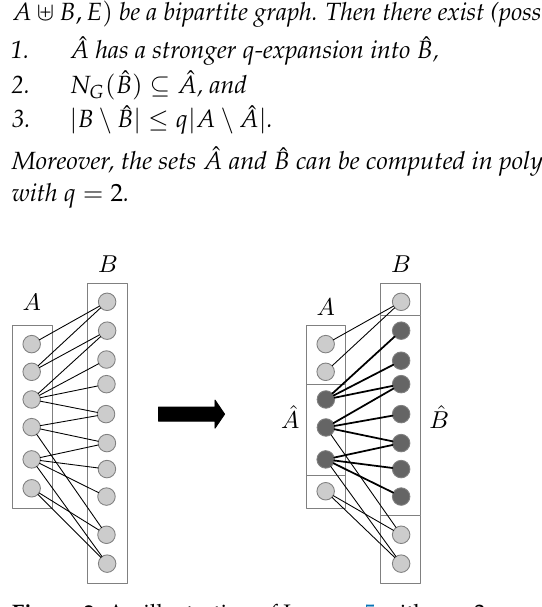
Figure 2. An illustration of Lemma 5 with q =